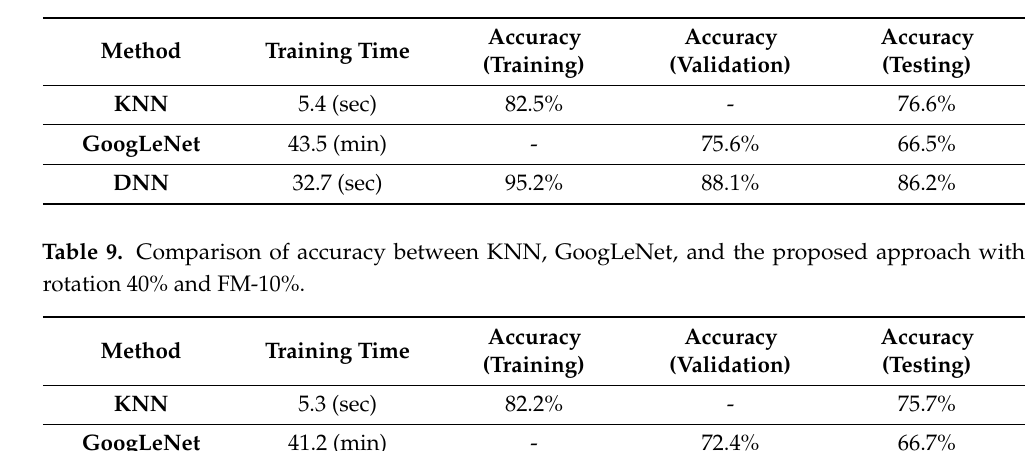
Table 8. Comparison of accuracy between KNN, GoogLeNet, and the proposed approach with 40% pre-emphasis.